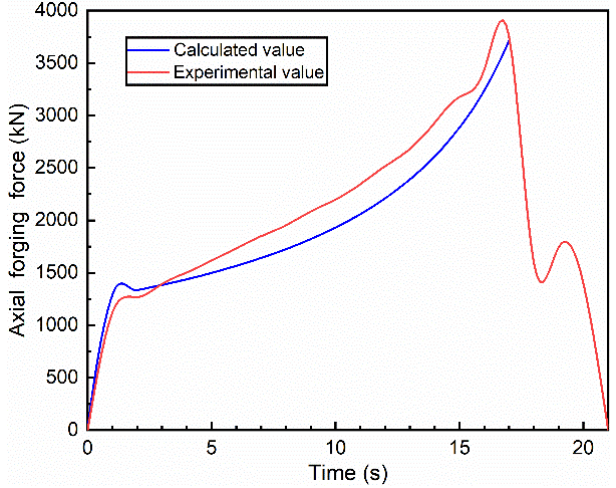
Figure 18. Comparison of axial forging force between experiment and theoretical